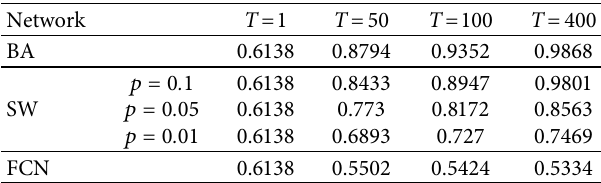
Table 6: Average difference statistics of interaction stages at dif- ferent times corresponding to Figures